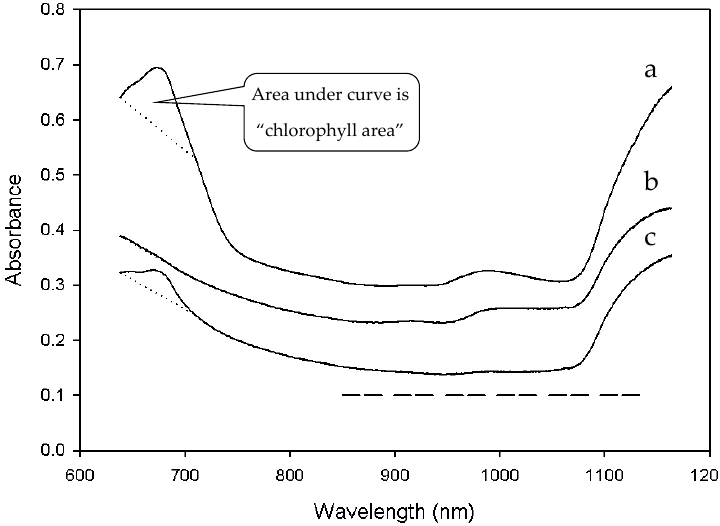
Figure 2. Illustration of spectral absorbance versus wavelength for grain with high (spectrum of line ‘a’), null (spectrum of line ‘b’) and low (spectrum of line ‘c’) amounts of foreign, green weedy matter. Areas under spectra from 638 nm and 710 nm above the baseline (dotted line) are “chlorophyll area” where green weedy matter in the grain stream is detectable. Also shown dashed line is the analysis region where protein concentration of grain is detectable.